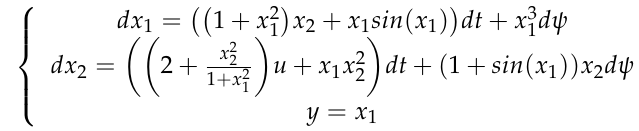
Figure 4. The states of the system (47).